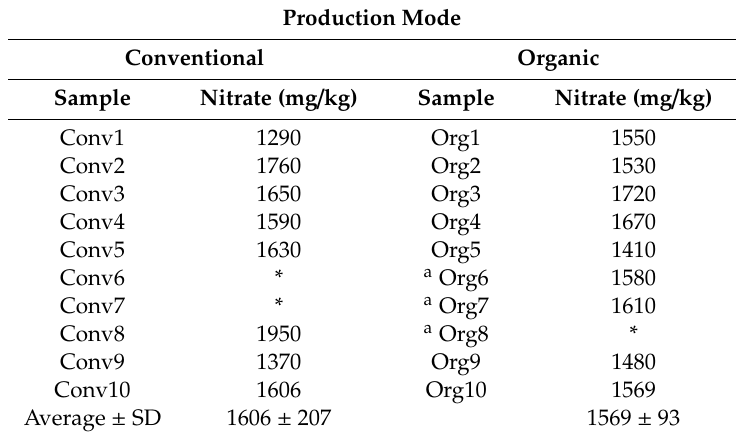
Table 3. Nitrate concentration in the organic and conventional lettuce